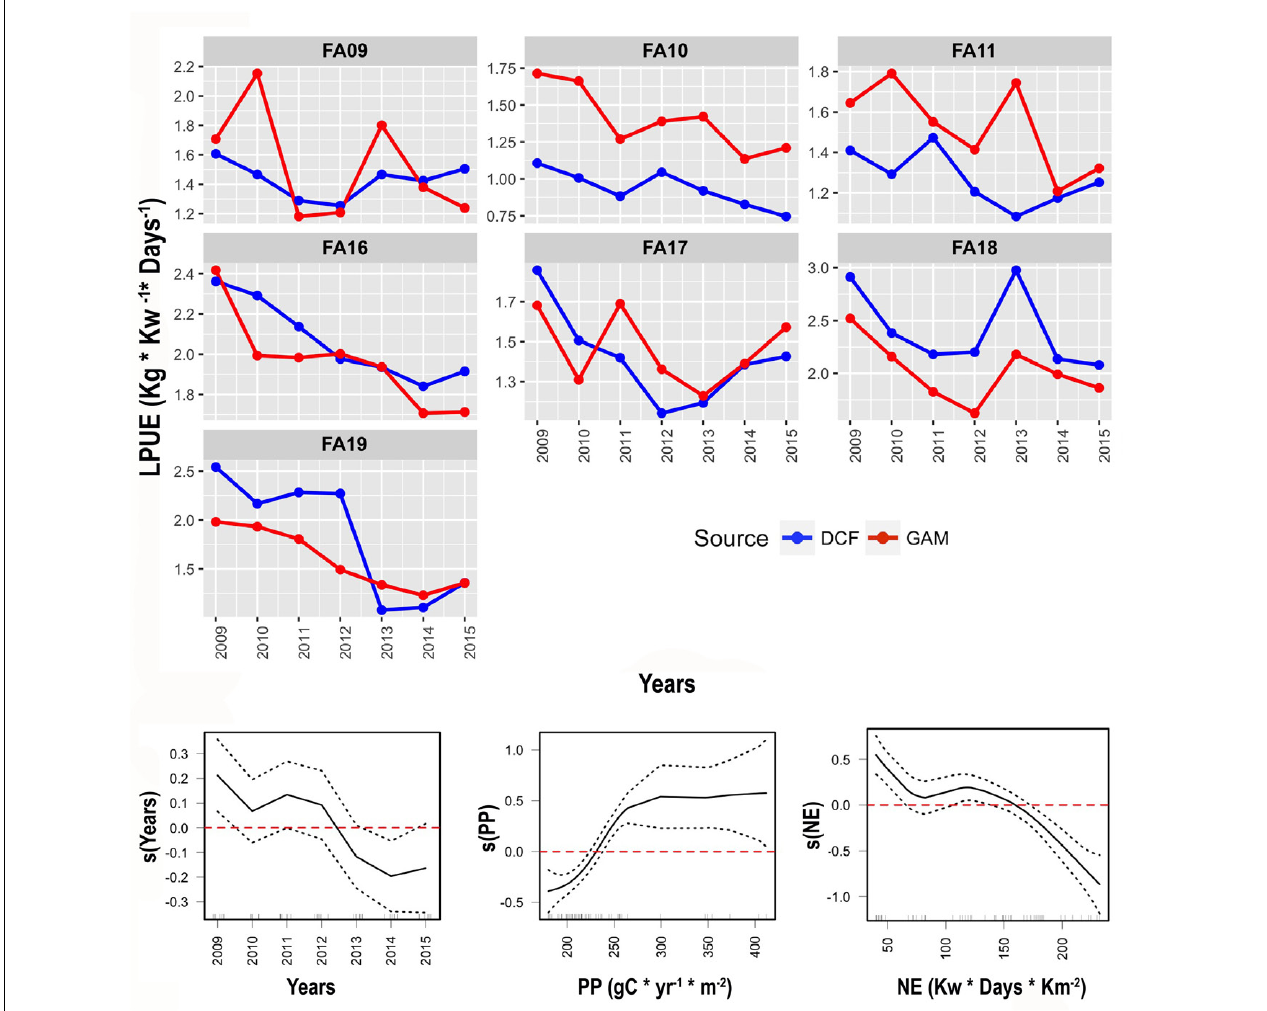
FIGURE 9 | (A) Comparisons between actual trends (source: DCF, blue lines and dots) and GAM-based models of LPUE, during the period 2009–2015. (B) The effects of the different predictors (if significant), independent of the other predictors, are represented as response variable shape. The degree of smoothing is indicated in the y -axis label. Confidence intervals (95%) around the response curve are represented by dashed